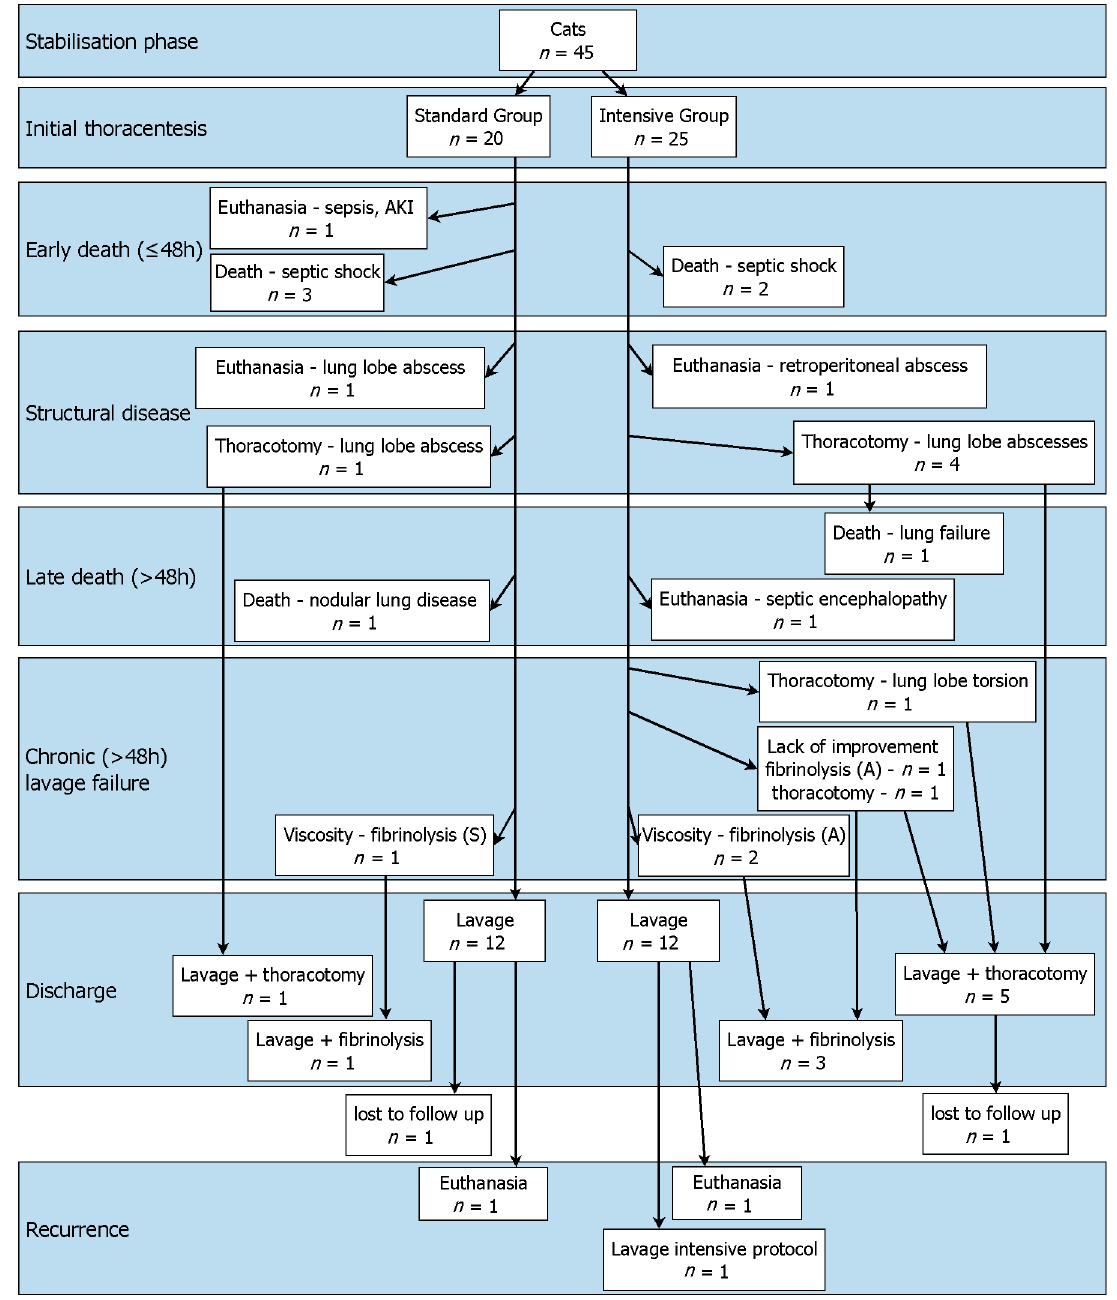
Figure 2. The organigram shows the development of the cats in this study during the hospitalisation. AKI acute kidney injury, S streptokinase, A alteplase. Overall, 53% (24/45) of the cats were successfully treated with small-bore thoracos- tomy tubes and closed-chest lavage alone. The 23 cats that were treated according to medical recommendations were discharged after a median of 10 days (range: 7 to 23